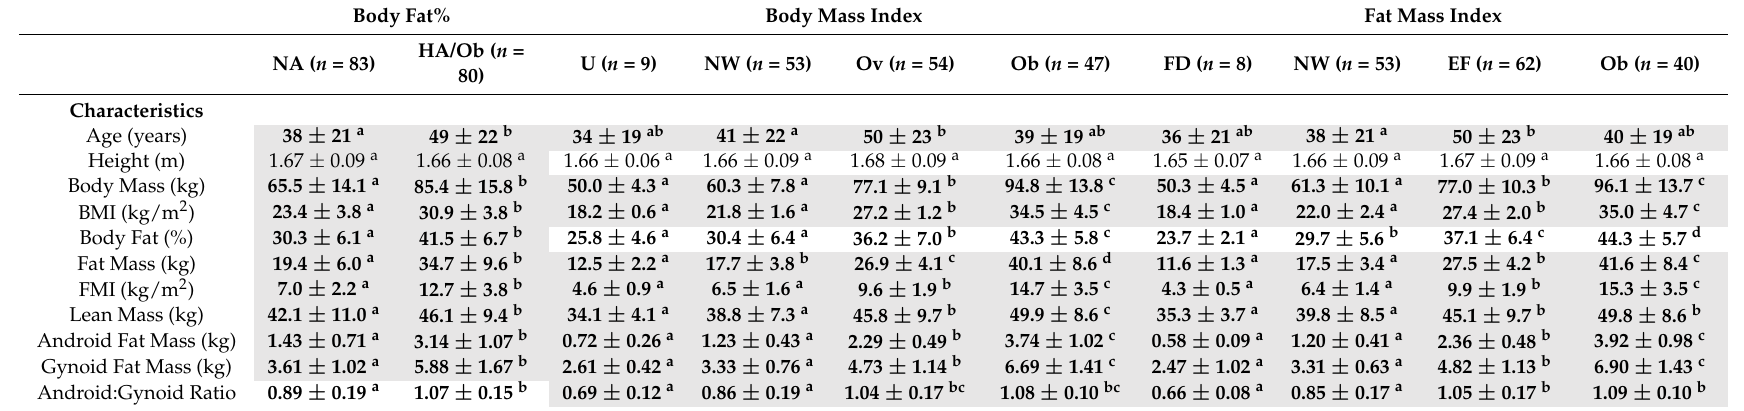
Table 1. A total of 163 untrained participants’ anthropometric characteristics categorized by three methods of classifying obesity (body fat%, body mass index (BMI) and fat mass index